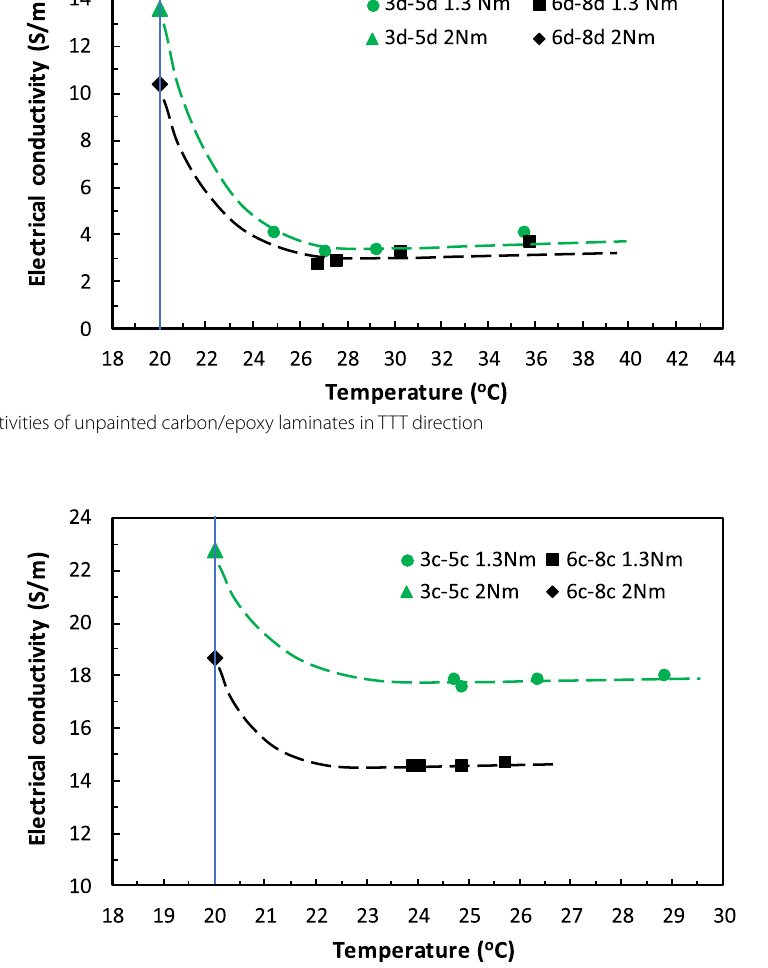
Fig. 15 Electrical conductivities of painted carbon/epoxy laminates in TTT